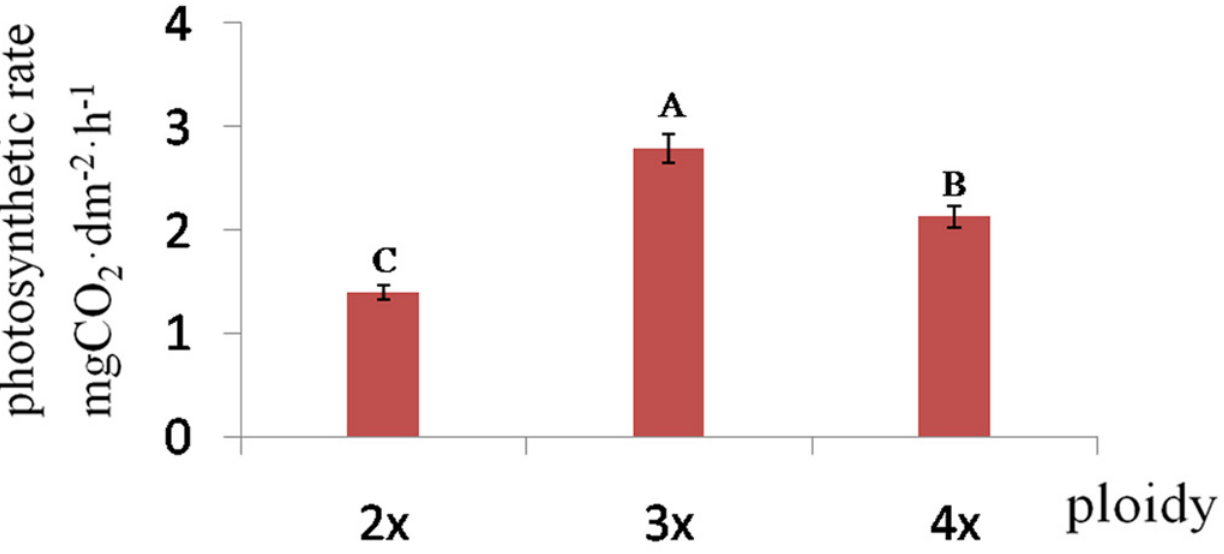
Fig 2. Photosynthetic rate of woad with different ploidy. A, B, C revealed that the photosynthetic rate were significantly different (P < 0.01) among 2 x , 3 x and 4 x plants.